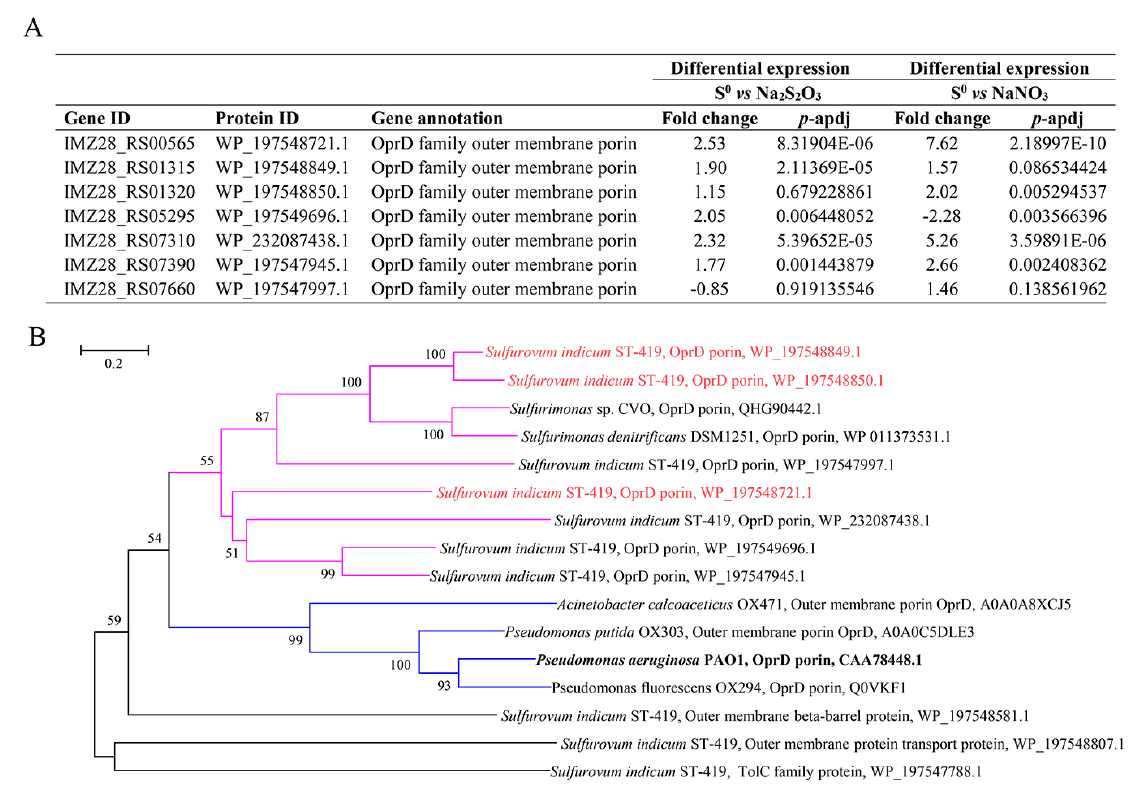
Figure 4. Transcriptomic analysis of genes associated with outer membrane proteins of strain ST-419 under S 0 oxidation and reduction ( A ). Phylogenetic relationships of outer membrane protein from strain ST-419 with homologous genes in the genera of Sulfurimonas , Acinetobacter and Pseudomonas ( B ). The three OprD proteins in red fonts have the highest expressions under S 0 oxidation and reduction. The OprD from Pseudomonas aeruginosa PAO1 in bold is the known characterized enzyme.